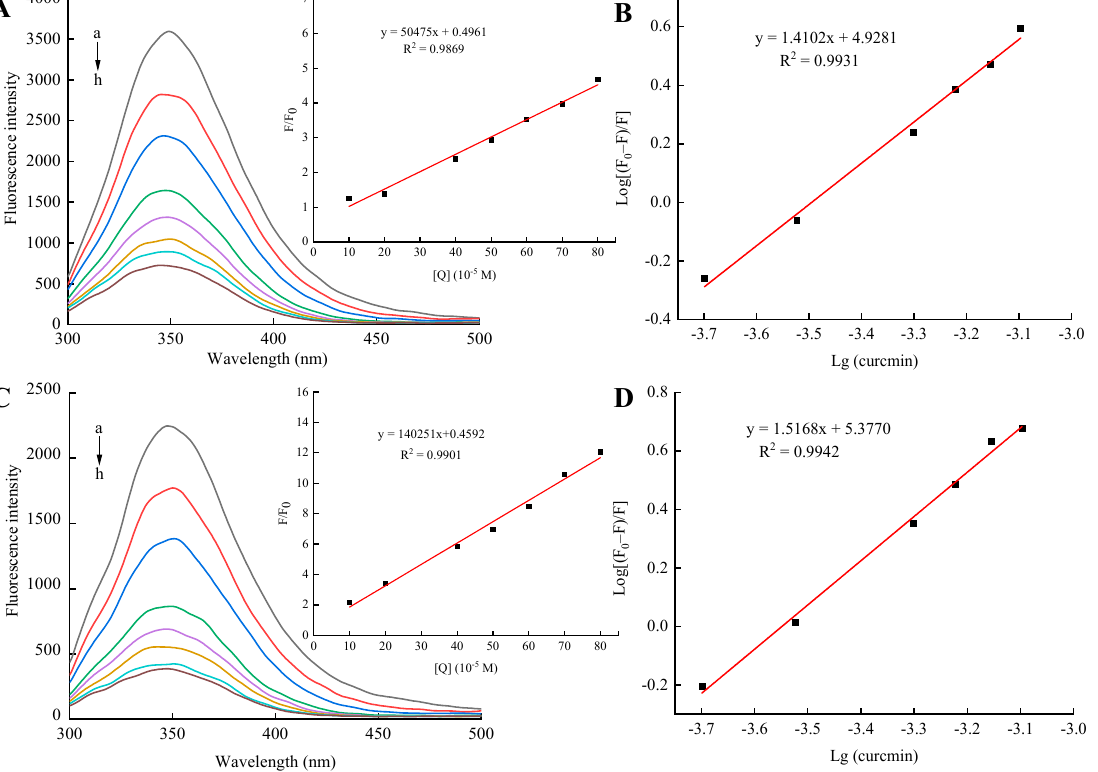
Figure 3. Fluorescence emission spectra of 7S ( A ) and 7S-150 ( C ) in the presence of various concen- trations of curcumin. The inset corresponds to Stern-Volmer plots for the quenching of 7S/7S-150 by curcumin. Conditions: Temperature, 25 °C; λ ex, 280 nm; 7S, 5 mg/mL; curcumin, 0-80 μ M (a–h). Logarithmic plots for the quenching of 7S ( B ) and 7S-150 ( D ) fluorescence by curcumin. 7S: soy β -conglycinin; 150: dextran (150 kDa).